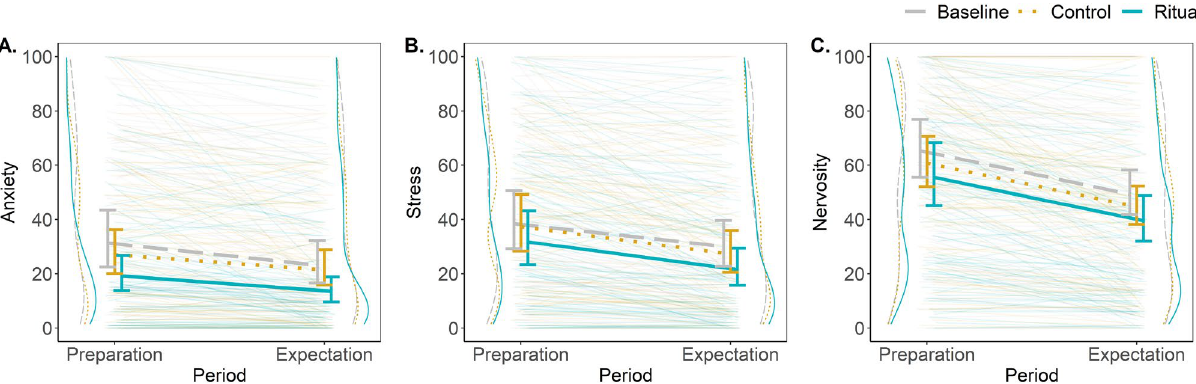
Figure 3. Estimated between-condition differences for the self-reported measure of anxiety ( A ), stress ( B ), and nervosity ( C ) on the full sample. Each plot includes density curves representing the raw distribution of data per each period and condition; raw data from all participants illustrating the dynamics of anxiety, stress, and nervosity; and estimated slopes with 95% CI for the between-condition differences. Data include the motor and verbal